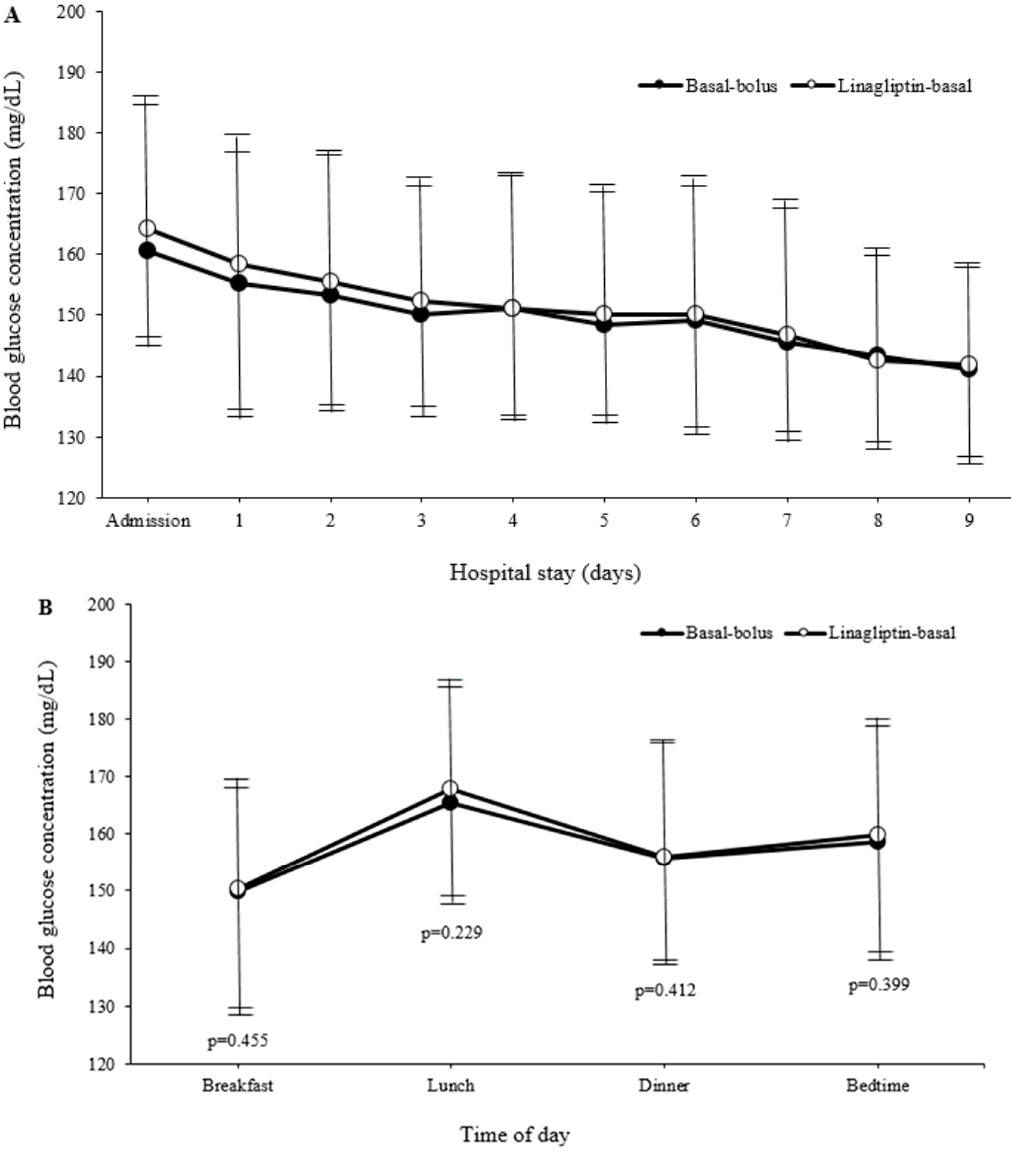
Figure 2. Mean daily blood glucose concentration during the hospital stay ( A ) and before breakfast, lunch, dinner and bedtime ( B ). Values are shown as mean ± standard deviations. mg/dL: Milligram/decilitre. No post-matching significant differences were observed in the comparison analysis between the basal bolus insulin regimen and linagliptin-basal insulin regimen in regards to mean daily BG concentration after admission (149.8 ± 13.5 vs. 151.2 ± 14.3 mg/dL, standardized difference = 0.011), number of patients with mean BG reading of 100–140 mg/dL (31 vs. 35, standardized difference = 0.017) and >200 mg/dL (14 vs. 24, standardized difference = 0.021) and number and day of treatment failure (43 vs. 47, standardized difference = 0.011; and 2.3 ± 1.1 vs. 2.1 ± 1.3, standardized difference =